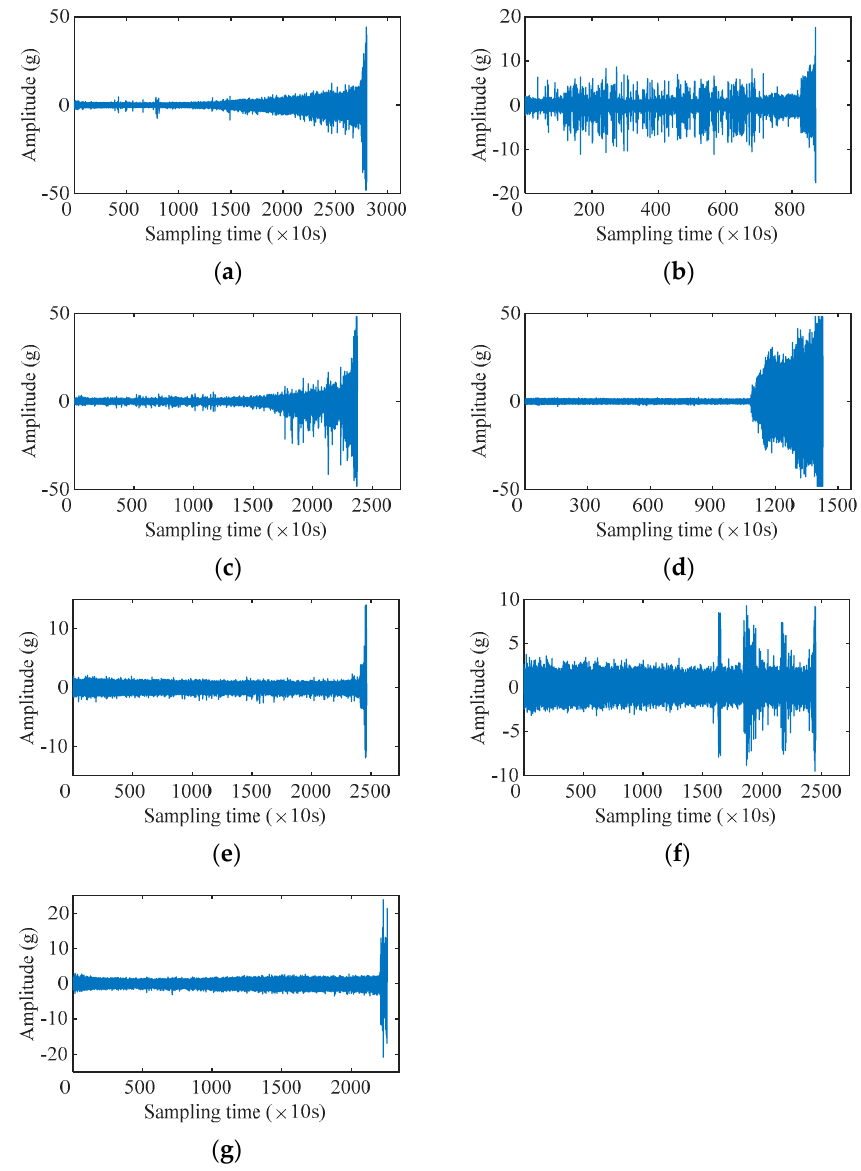
Figure 7. Original waveforms of seven bearings under working condition 1: ( a ) Bearing1_1; ( b ) Bear- ing1_2; ( c ) Bearing1_3; ( d ) Bearing1_4; ( e ) Bearing1_5; ( f ) Bearing1_6; and ( g ) Bearing1_7.